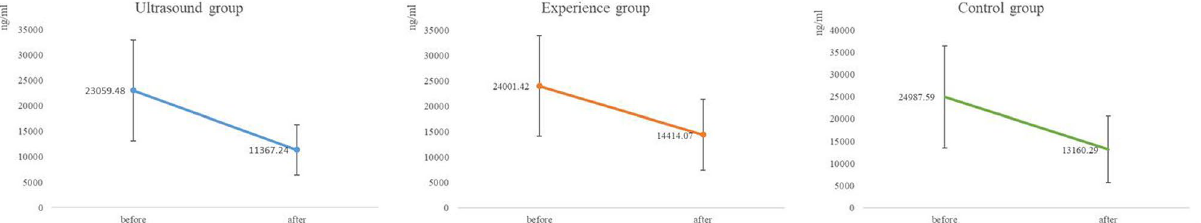
Figure 1. Changing trend of NT-proBNP among three groups.